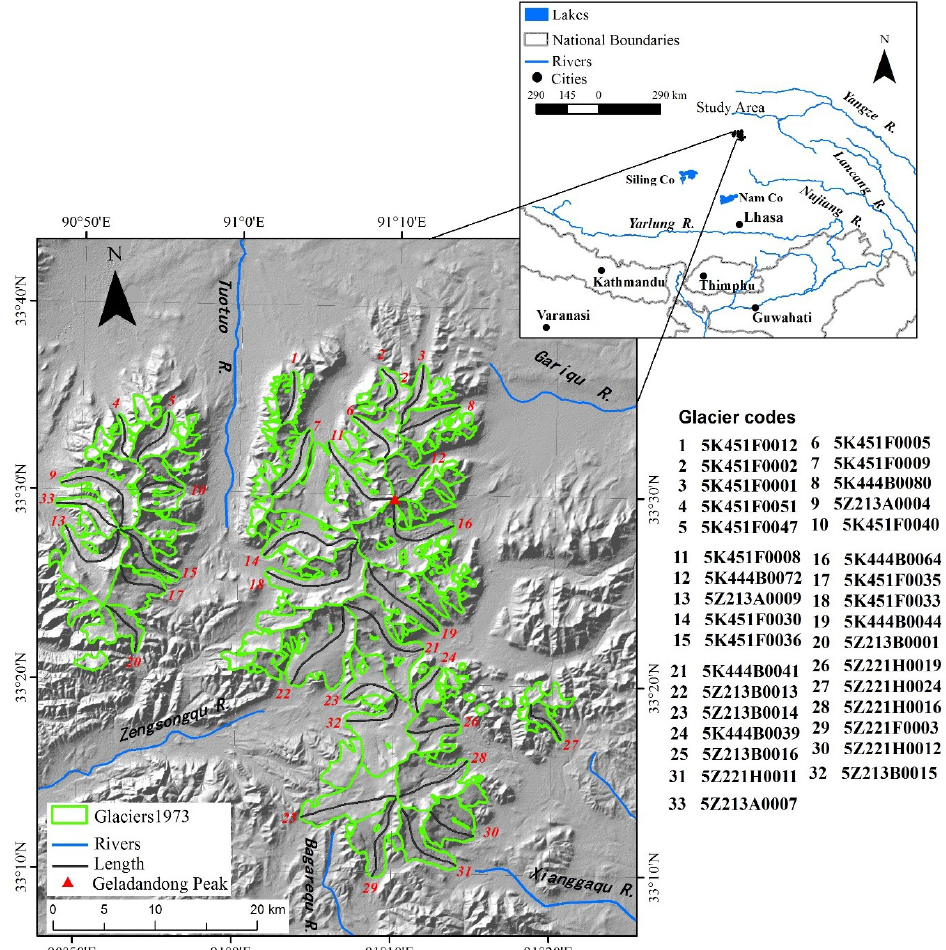
Figure 1. The location map of the study area and the main glacier codes.